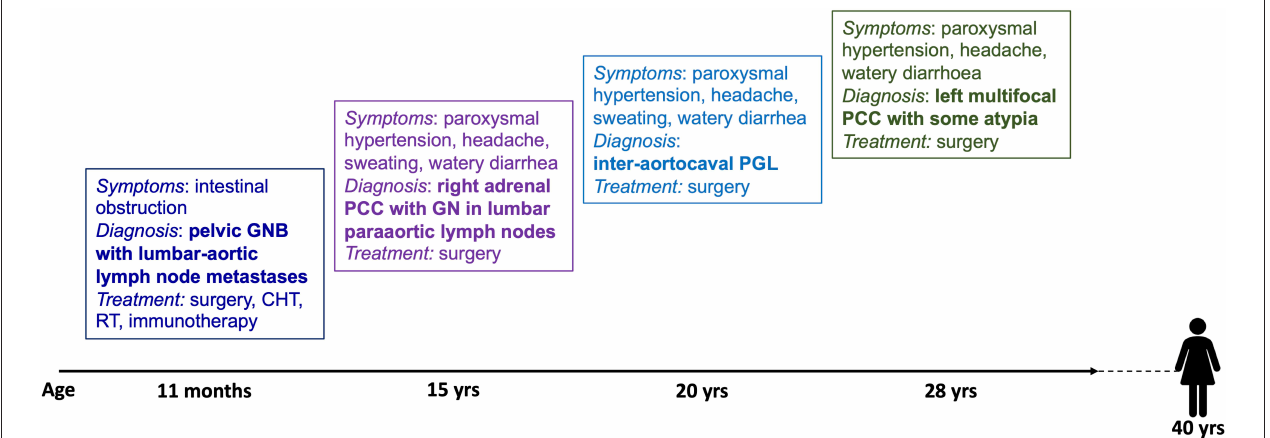
FIGURE 2 | Timing of the presentation of multiple and composite NEN-neural tumors in this patient. GNB, ganglioneuroblastoma; CHT, chemotherapy; RT, radiotherapy; PCC, pheochromocytoma; GN, ganglioneuroma; PGL, paraganglioma.